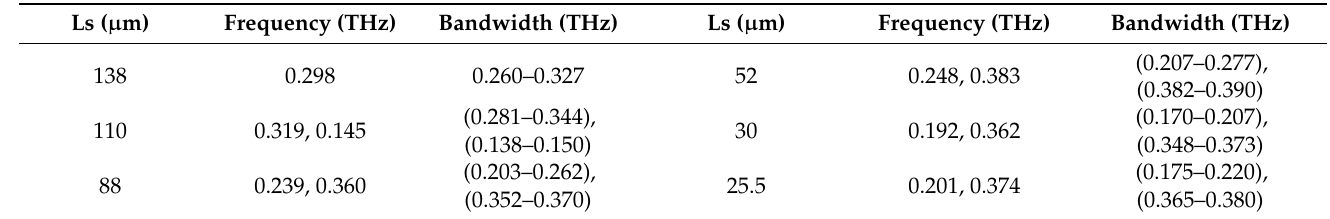
Figure 8. Metamaterial simulation set up: ( a ) on Z -axis; ( b ) on Y -axis. Table 3. Performance comparison of the proposed MTM for different slotted-strip line lengths.